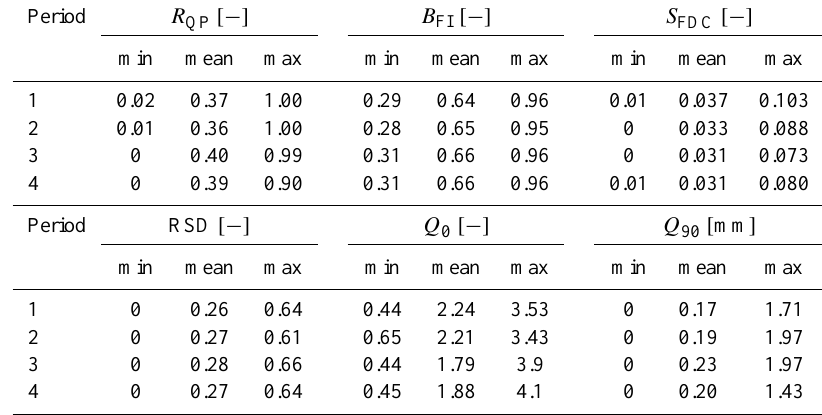
Table 2. Minimum, mean, and maximum values for the six signature classes across each of the four periods. Period R QP [−] B FI [−] S FDC [−] min mean max min mean max min mean max 1 0.02 0.37 1.00